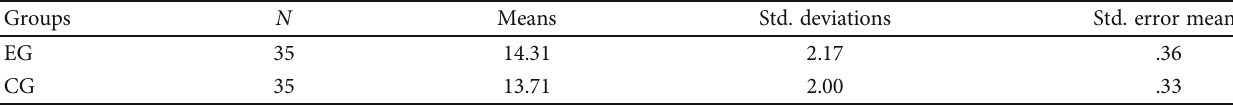
Table 1: Groups ’ listening pretest (descriptive statistics).